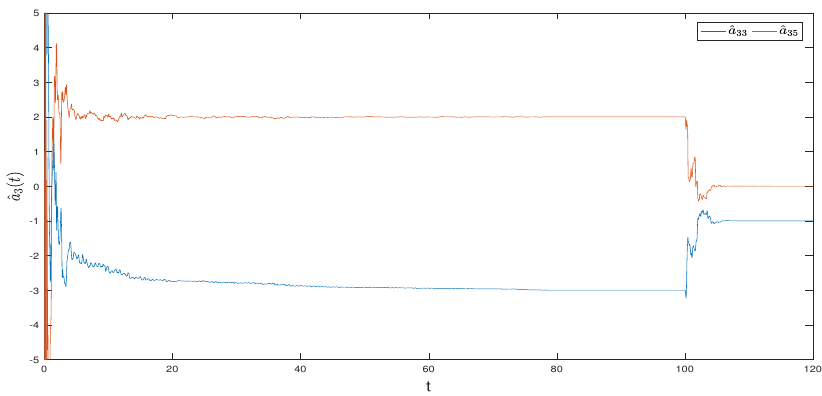
Figure 5. (Color online) Identification of the switching